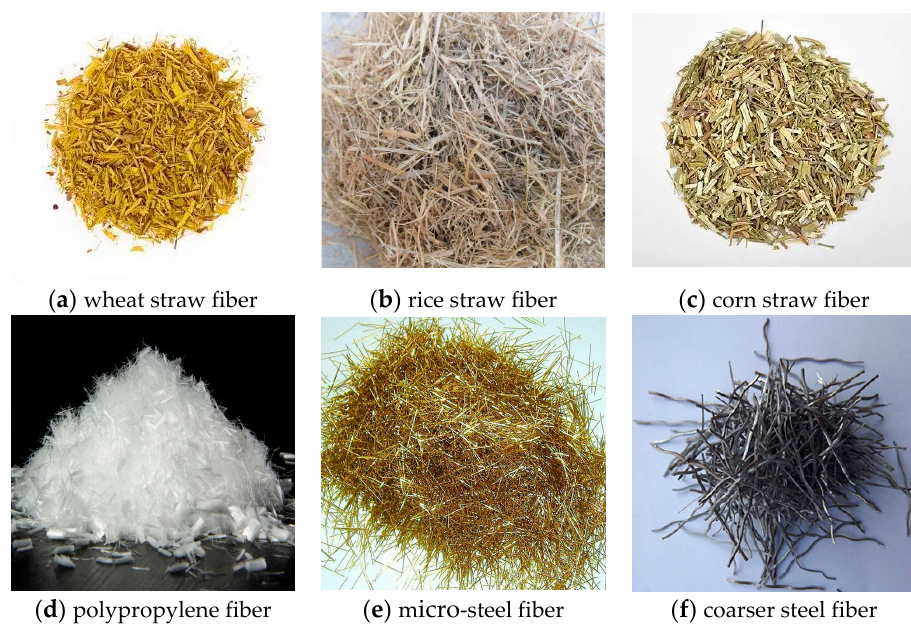
Figure 1. The fibers used in alkali-activated BFS.